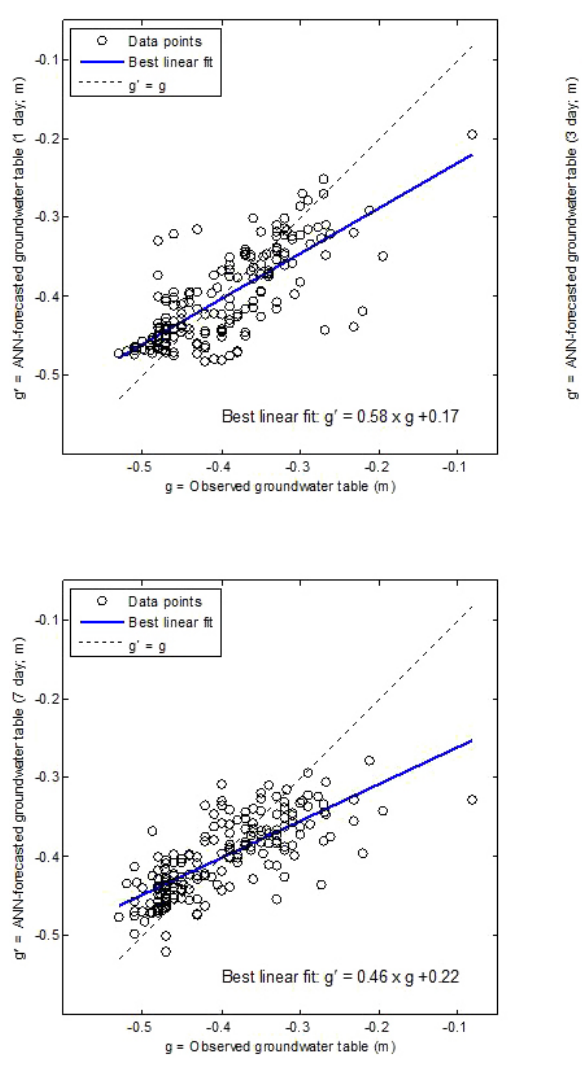
Figure 5. Scatter plots of observed and ANN-forecasted groundwater tables